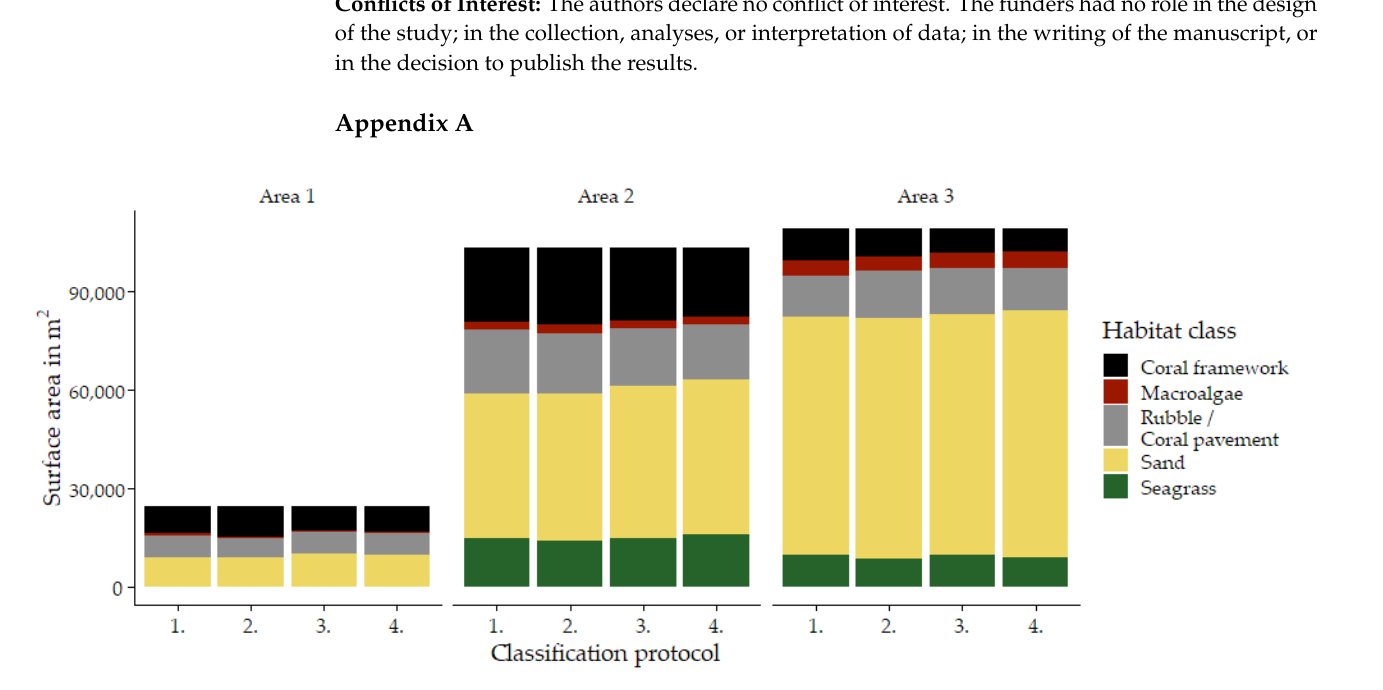
Figure A1. Surface area of each habitat as classified in eCognition separated by survey area and classification protocol (Figure 1, and Table 2). Classification protocols are indicated by their number (Table 2): 1. ‘Traditional classification’, 2. ‘Using reef zones’; 3. ‘Using geomorphometric features’; 4. ‘Reef zones and geomorphometric features’.